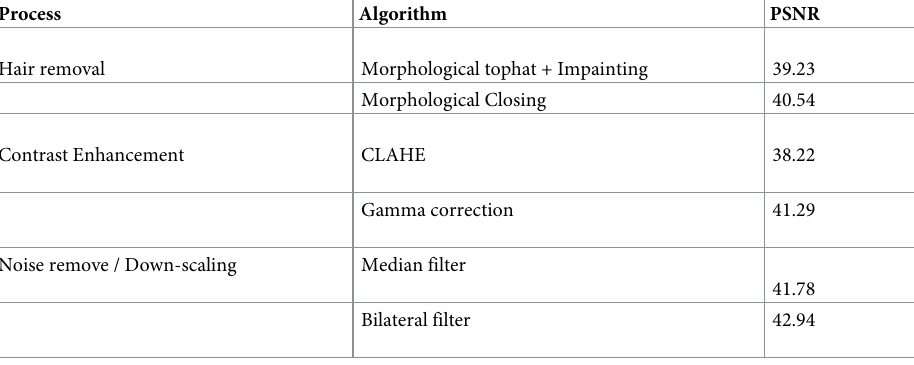
Table 3. Comparison of different approaches based on PSNR